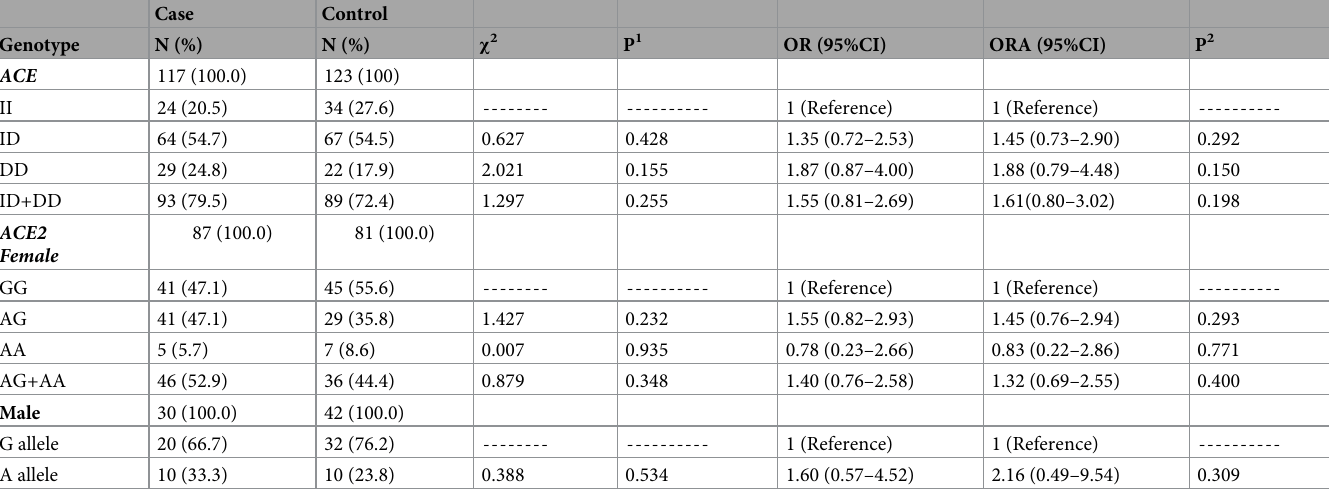
distribution of genotypic and allelic frequencies of ACE I/D and ACE2 G8790A polymor- phisms between case and control groups (analysis by qui-square test). Considering the risk analysis for each gene (Table 2), there was no significant association between the ACE I/D and ACE2 G8790A polymorphisms and the susceptibility to SAH (p > 0.05). Table 2. Distribution of genotypic frequencies for ACE I/D and ACE2 G8790A polymorphisms in the study population and a risk analysis for